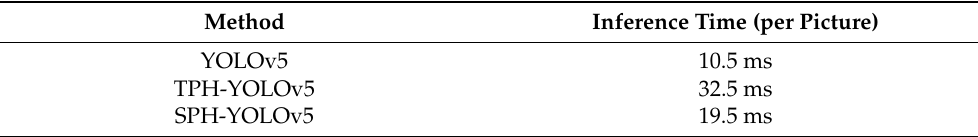
Table 4. Inference time on the DOTA test dataset for different detection